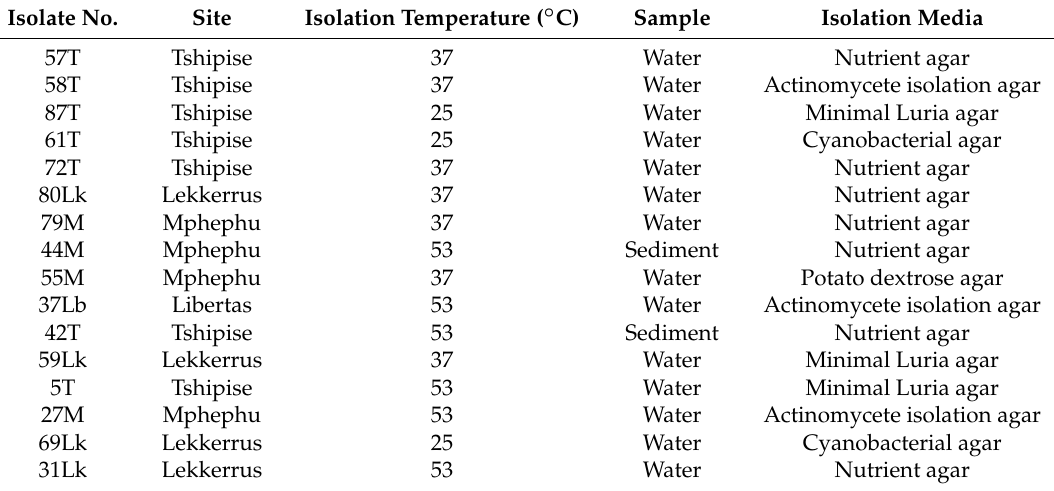
Table 2. List of Actinobacteria and Proteobacteria isolates with isolation conditions given. Isolate